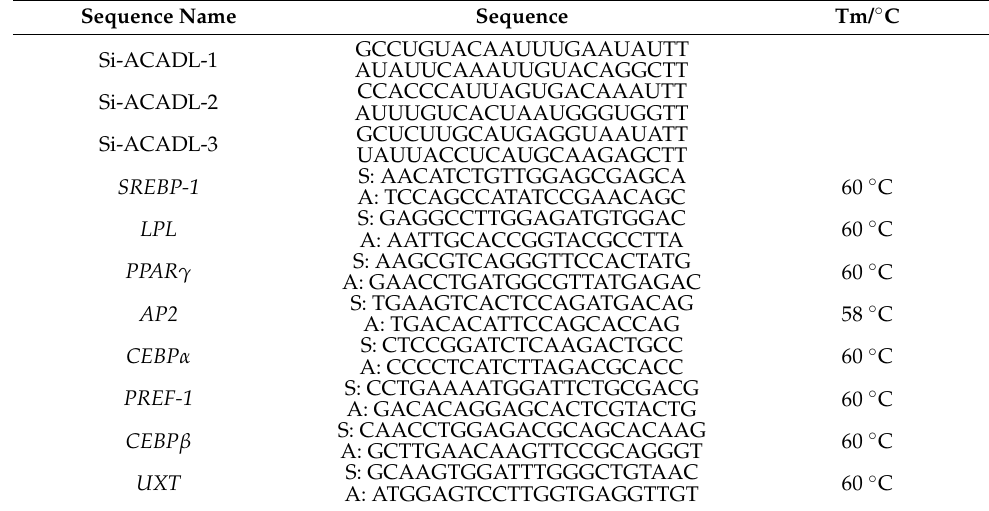
Table 1. Information of sequences and